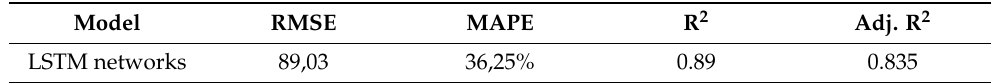
Table 10. LSTM network model results.